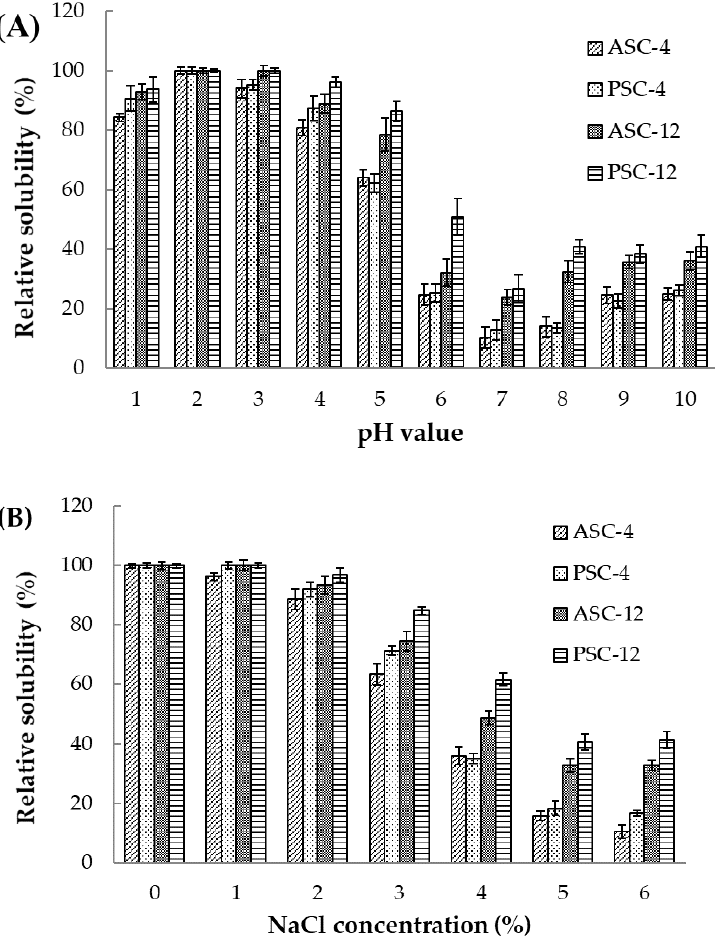
Figure 8. The effect of pH ( A ) and NaCl ( B ) concentration on the solubility of ASC and PSC extracted at 4 and 12 °C from the skin of pufferfish.